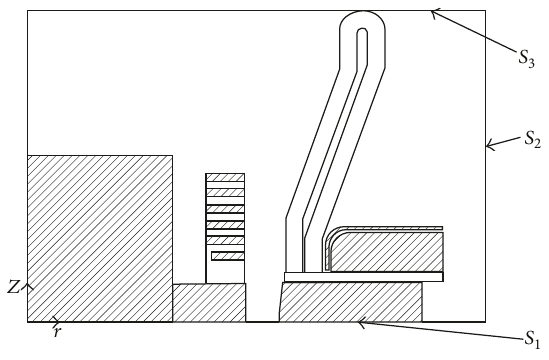
Figure 2: Cross section of the solution